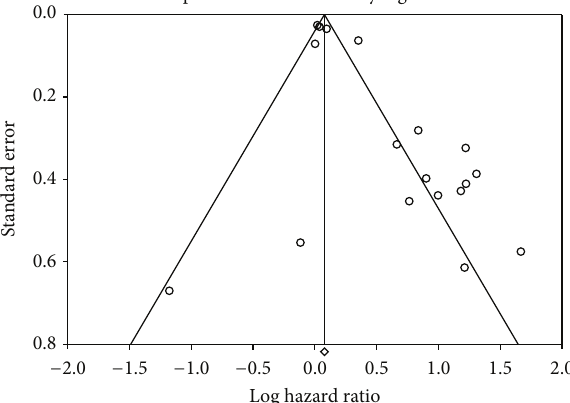
Figure 9: Publication bias pooled association between MVD expression and overall